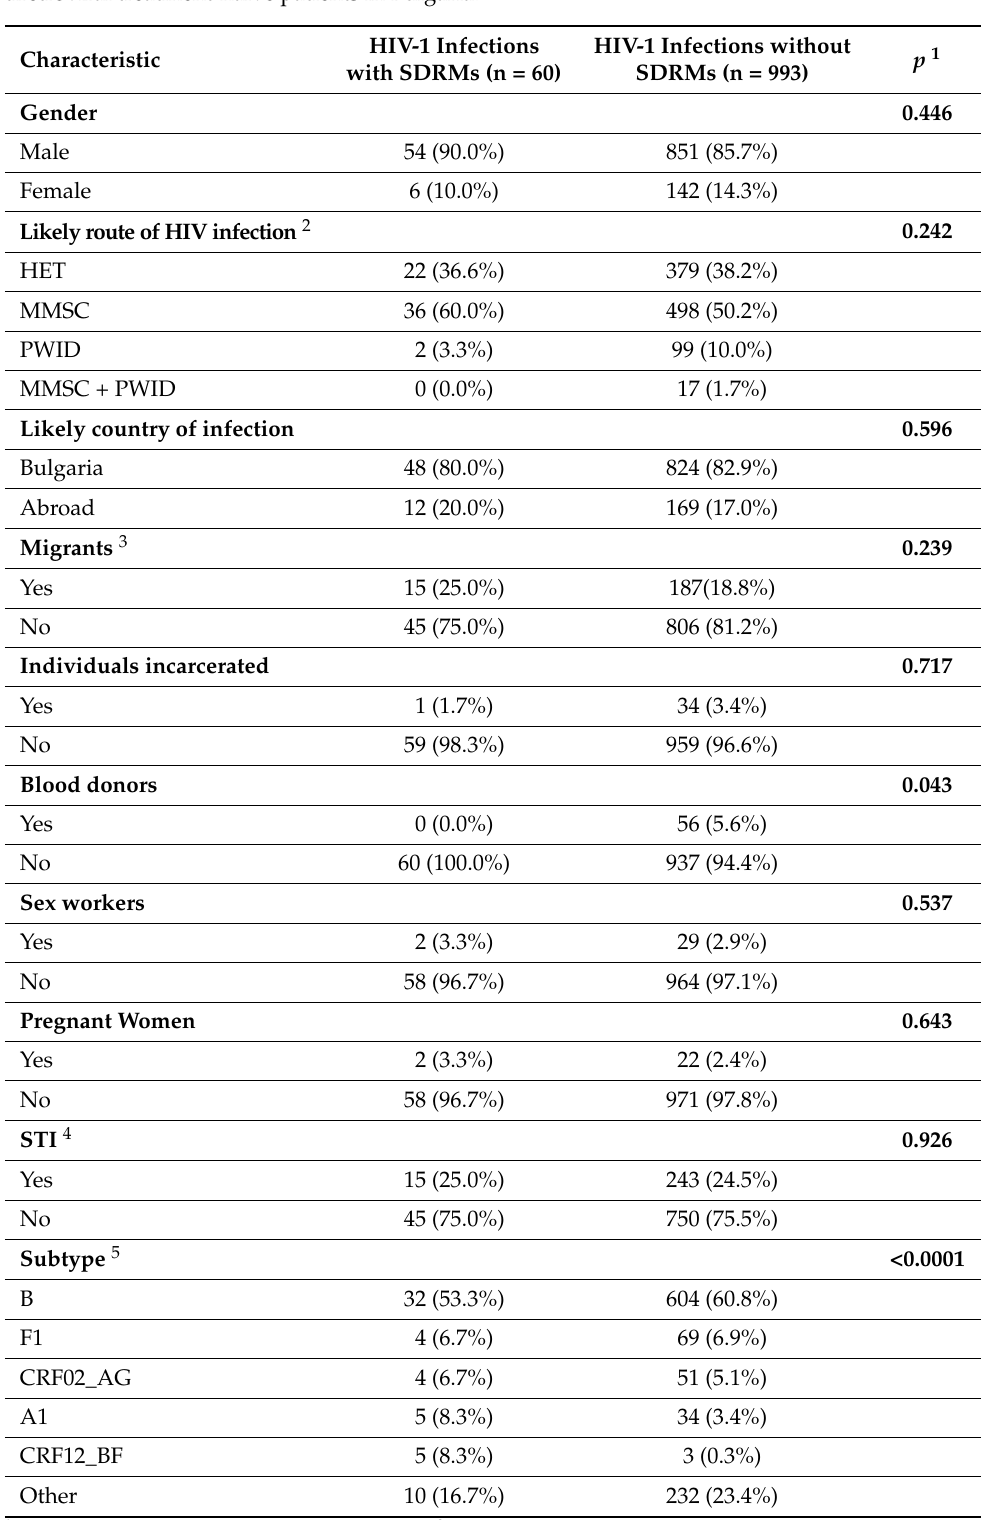
Table 1. Prevalence and characteristics of surveillance drug resistance mutations (SDRMs) in an- tiretroviral treatment-naive patients in